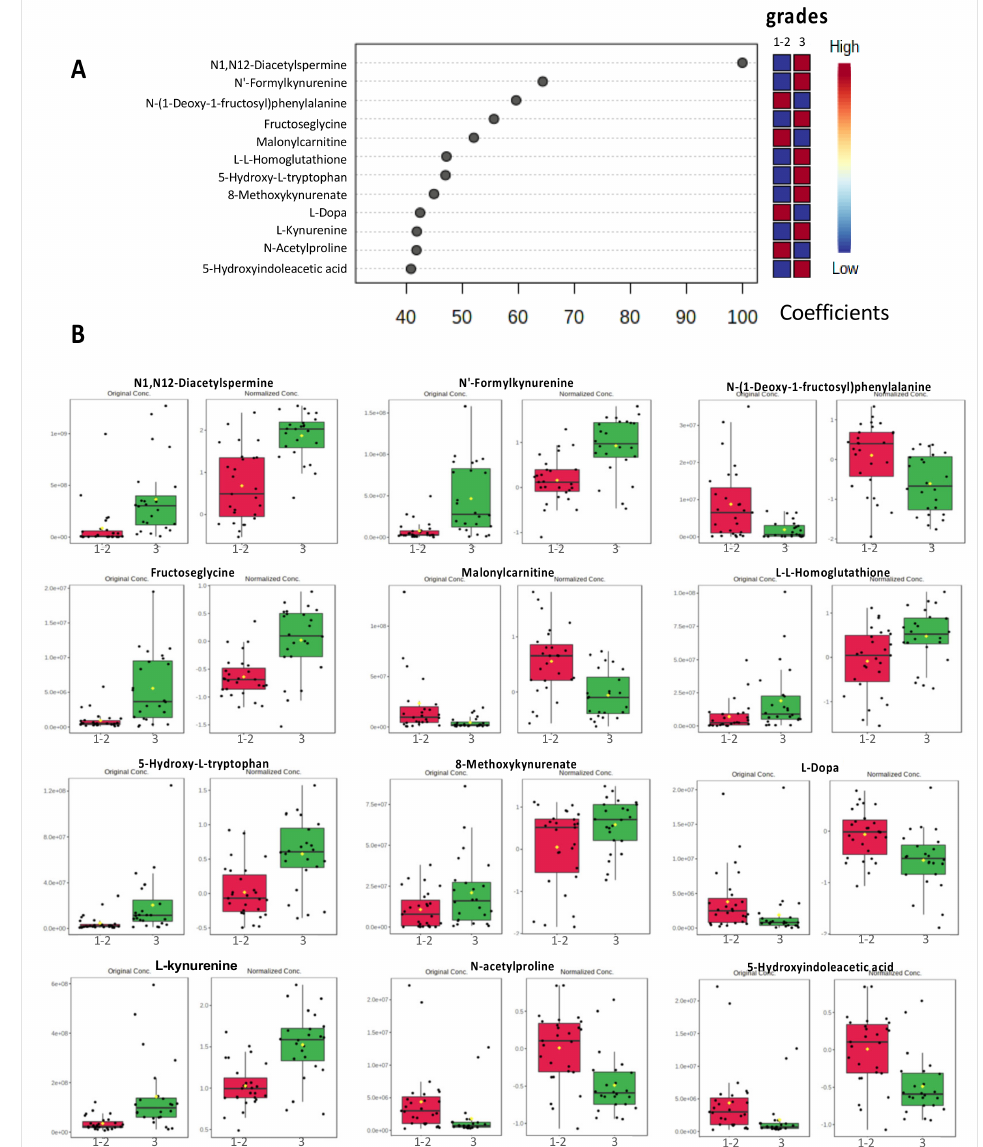
Figure 3. Importance and variation of the top 12 most important metabolites. ( A ) shows the coefficient score plot for the top 12 most important metabolite features identified by PLS-DA. In the right column, the relative concentration of the metabolite is represented in blue when reduced or in red when increased. ( B ) Box plots illustrate the relative concentration of the top 12 most important metabolite features identified by PLS-DA in high-grade (grade III—green boxes) and low-grade (grade I-II—red boxes) groups. The exact names of the metabolites were verified by matching experimental MS2 results with MS2 databases